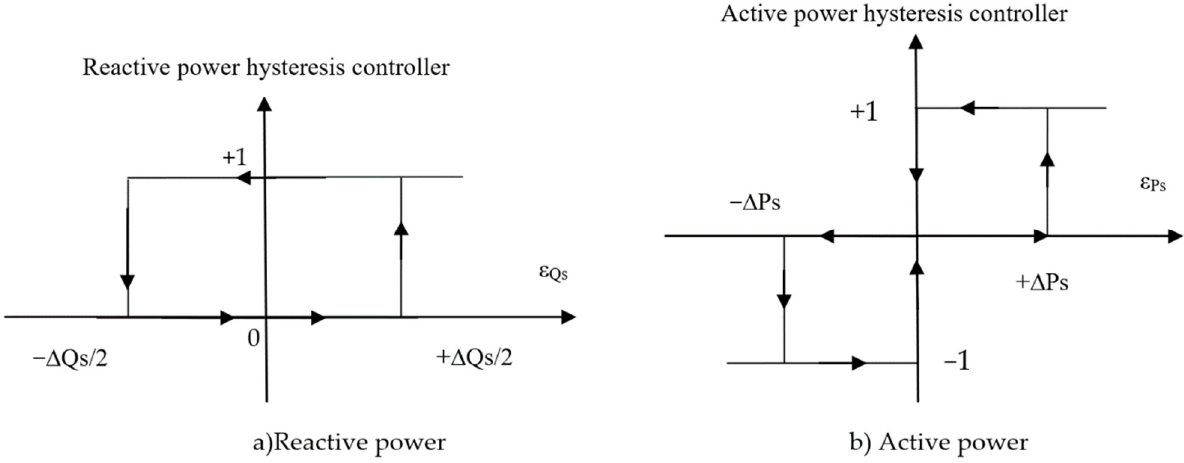
Figure 4. Scheme block of the hysteresis comparators.